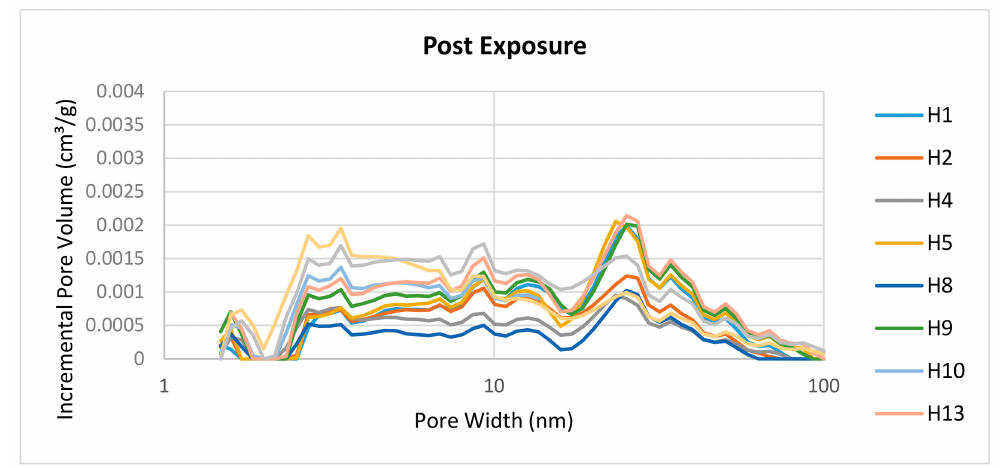
Figure 9. Pore size distributions for the samples analysed after exposure to scCO 2